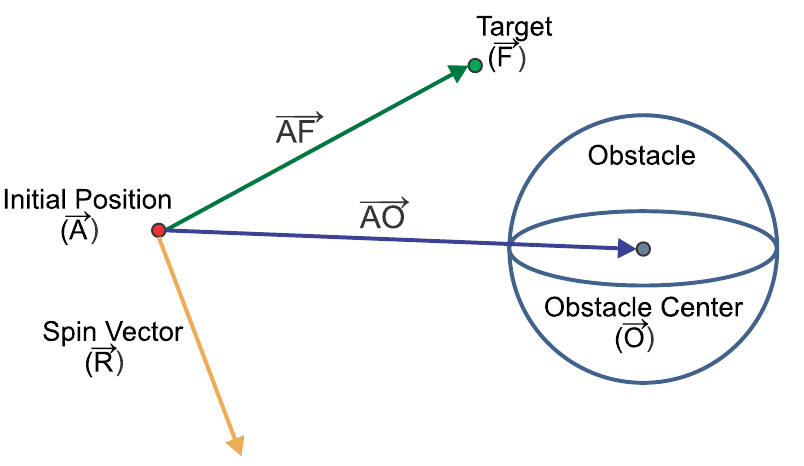
Figure 3. Determining the spin vector of the vortex field.